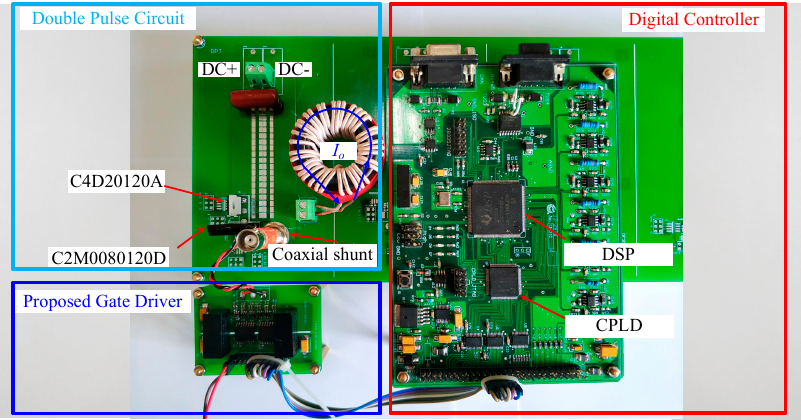
Figure 7. Double-pulse test platform based on the proposed gate driver.